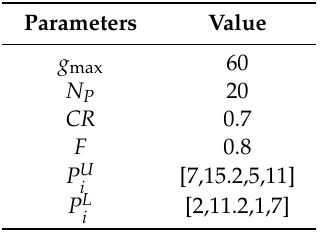
Table 5. Initial parameters of the DE algorithm.